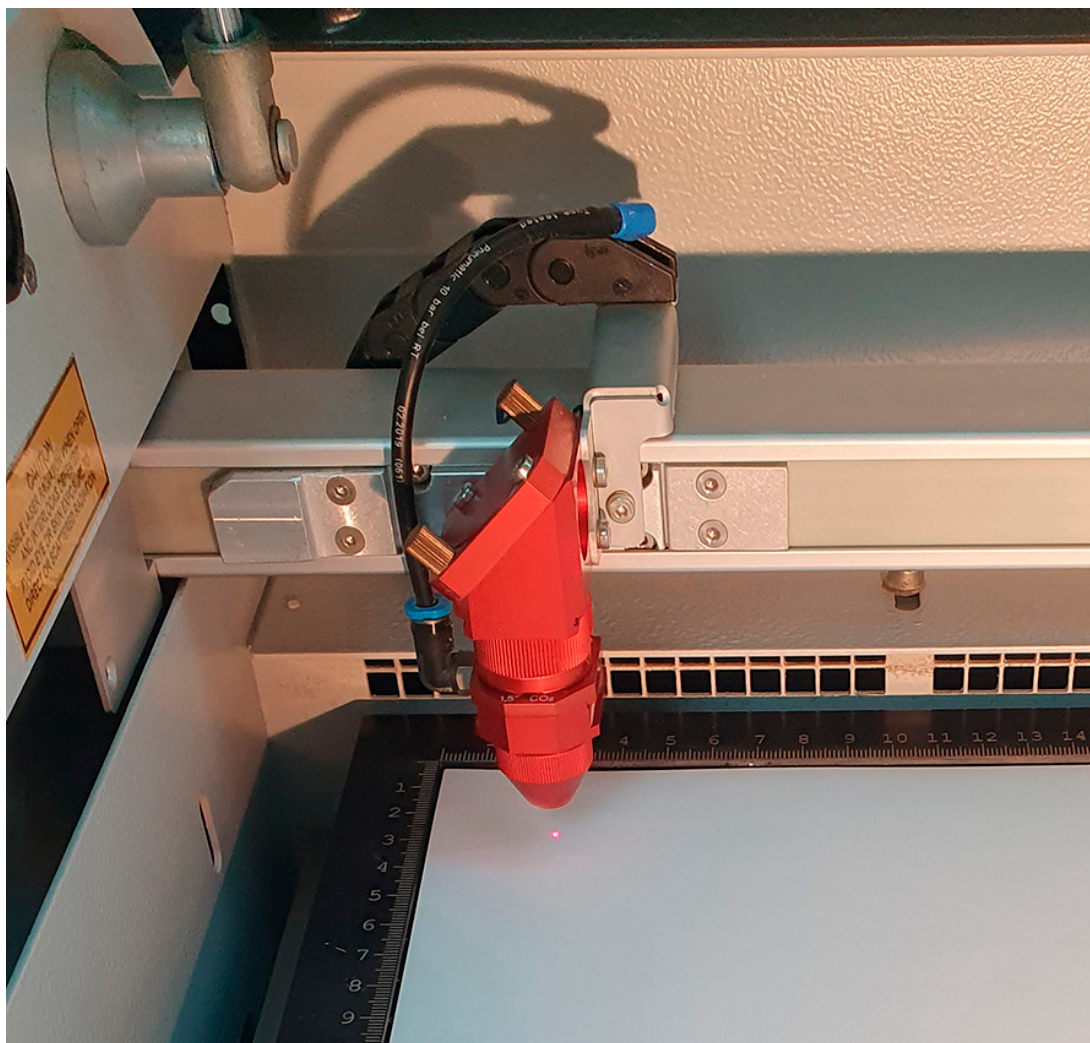
Figure 2. Laser cutting